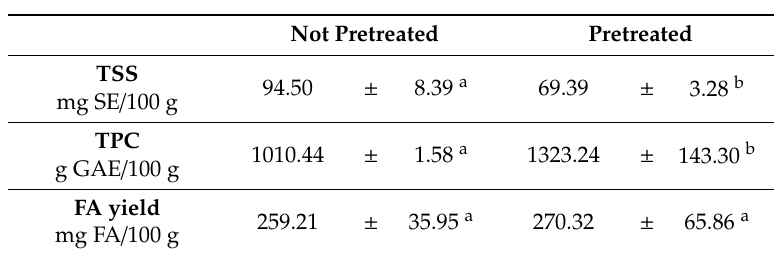
Table 4. Comparison of the results obtained for alkaline hydrolysis of not pretreated and treated BSG (1 h). Total soluble solids (TSS) is expressed as mg of sucrose equivalent per 100 g of BSG, total phenolic content (TPC) is expressed as gram of gallic acid equivalent per 100 g of BSG, and FA yield is expressed as mg of FA per 100 g of